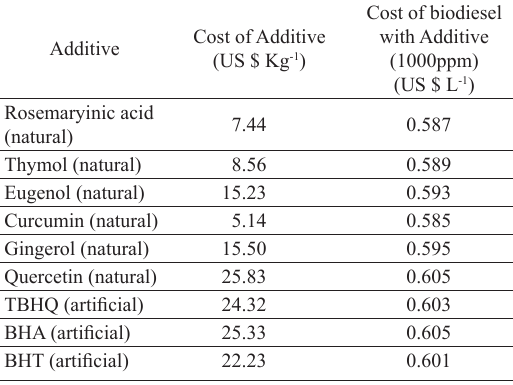
Table 1. Cost of additives (R$ Kg -1 ) and cost of biodiesel with Additive (1000ppm) (US$ L -1 ).